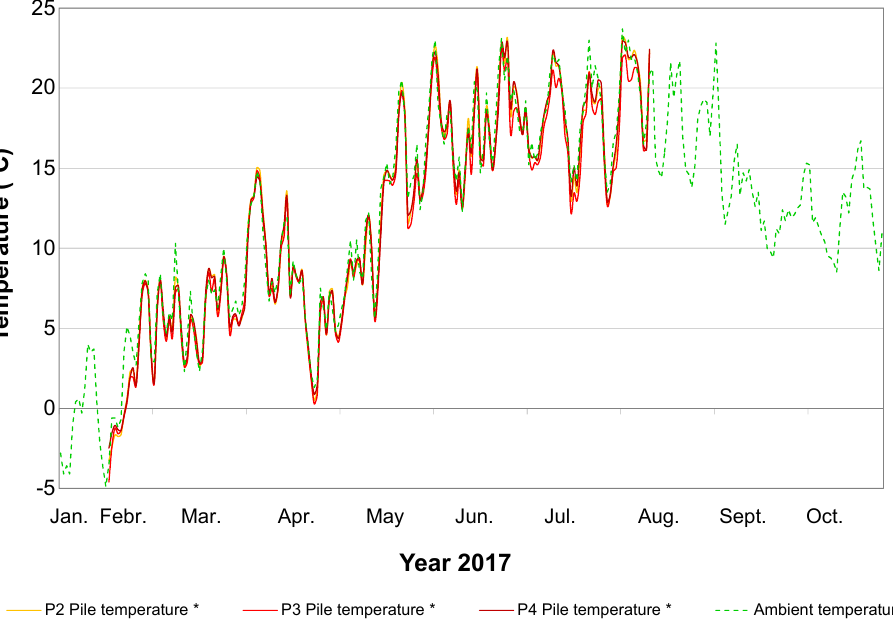
Figure A1. Pile temperatures and ambient temperature during storage trials P2–P4 in Schwarzbach. (* daily average).